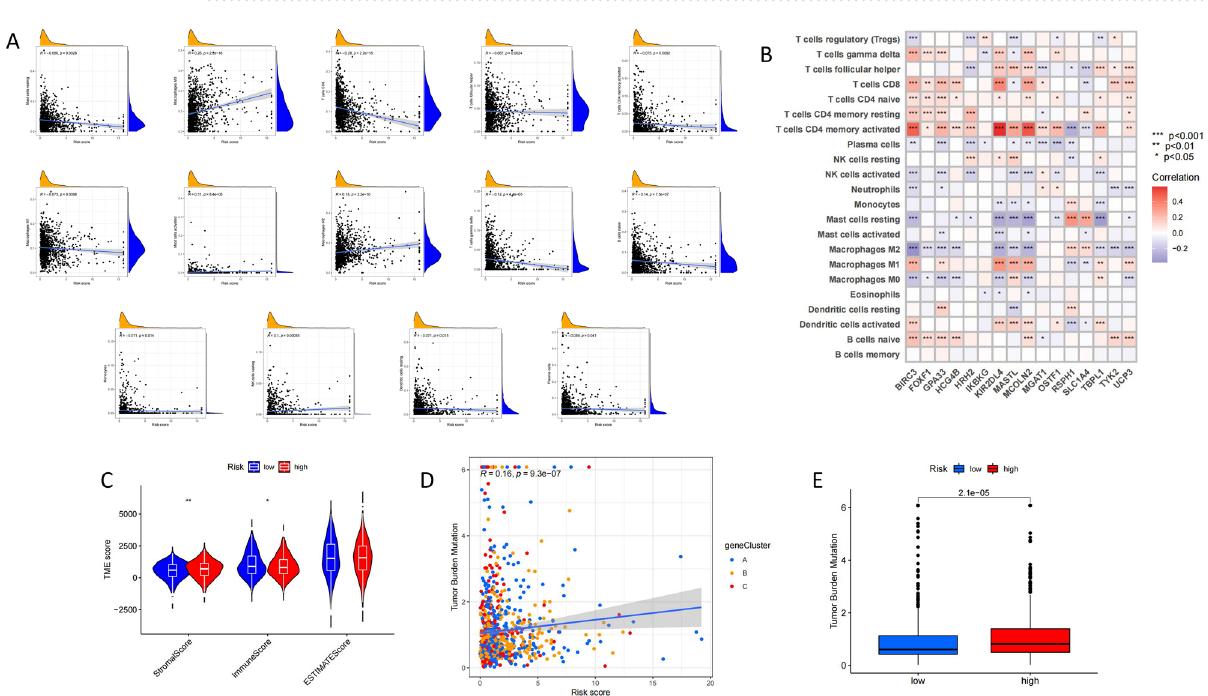
Figure 8. Correlation between risk scores and characteristics of the tumor immune microenvironment. ( A ) Correlation between risk score and immune cell type. ( B ) Correlation between the abundance of immune cells and the 16 genes in the risk model. ( C ) Correlation between risk scores and immune cell and stromal cell scores. ( D ) Correlation between risk score and TMB and genotyping. ( E ) The role of TMB in different risk score